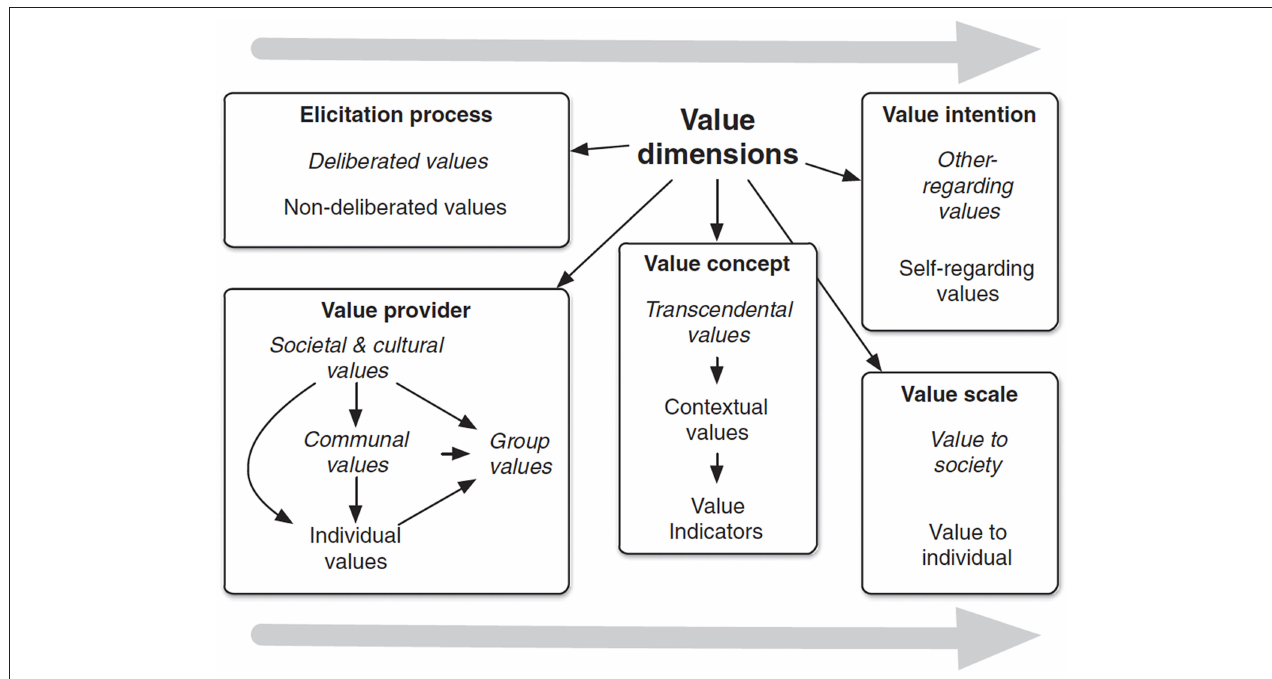
FIGURE 11 | Shared and social values framework: the five dimensions and seven main types of shared and social values. Bold titles indicate non-mutually exclusive dimensions of value. Emerging from the dimensions, we can differentiate between types of values that might be termed shared, social, or shared social values (italicized) and other types of values. For example, provider is a dimension that indicates who might provide values in a valuation setting; societies, cultures, communities, and ad-hoc groups provide societal, cultural, communal, and group values, which are all types of shared or social values. Individuals also provide values, but these are not termed shared or social, unless they can be classified as such on a dimension other than that of value-provider. Arrows within boxes indicate directions of influence between different types of values. Gray arrows signify that the type of elicitation process and value provider strongly influence what value types are articulated along the concept, intention and scale dimensions (Modified from Kenter et al.,